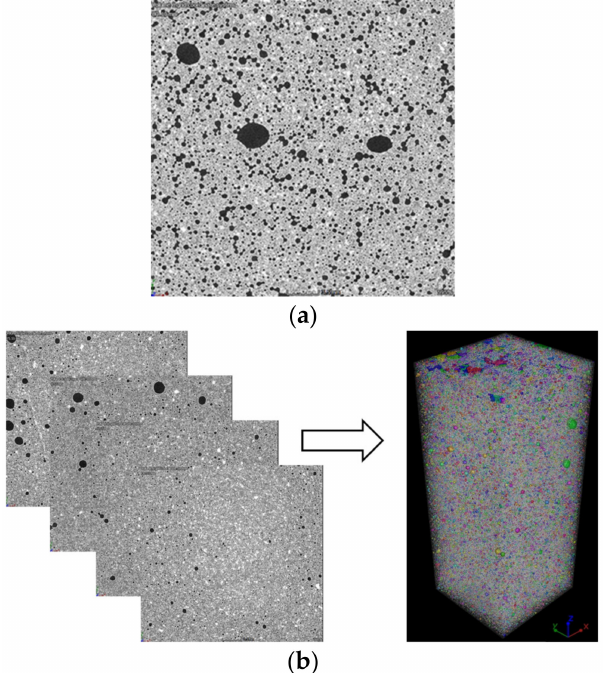
Figure 3. X-CT images of test specimen: ( a ) 2-D image, ( b ) 3-D reconstructed